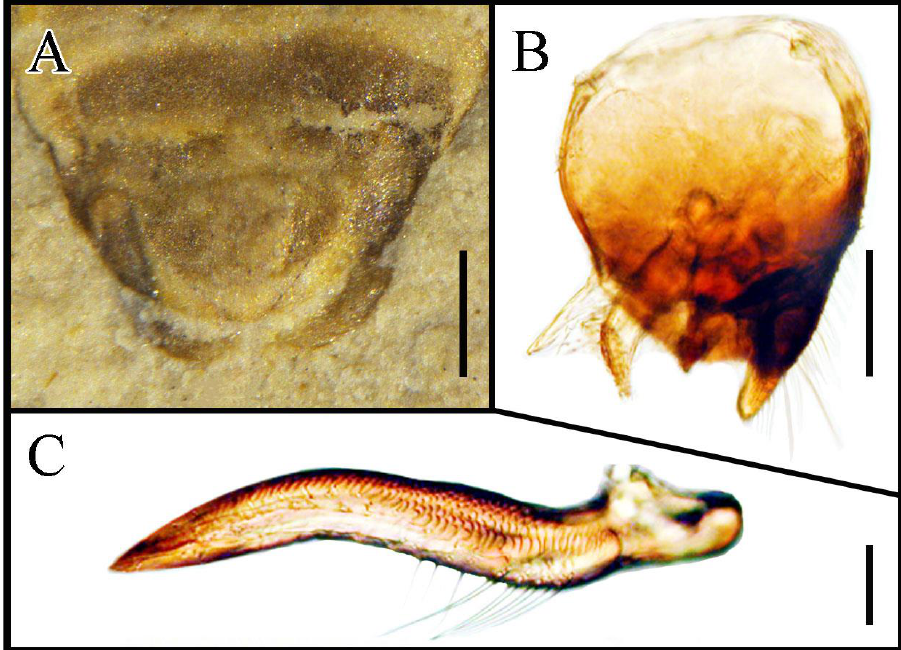
Figure 3. Comparison of male genitalia. ( A ) Pachymeridiidae Varicapitatus sinuolatus gen. et sp. nov. male genitalia, dorsal view, male, CNU-HET-LB2022003. ( B ) Lygaeoidea Rhyparochromidae Mizaldus sylvaticus Krüger, 2019 male genitalia, lateral view. ( C ) Lygaeoidea Rhyparochromidae Mizaldus carvalhoi Slater, 1995 male Paramere. (Krüger, 2019). Scale bars: ( A ) = 0.2 mm; ( B ) = 0.1 mm; ( C ) = 0.05 mm.